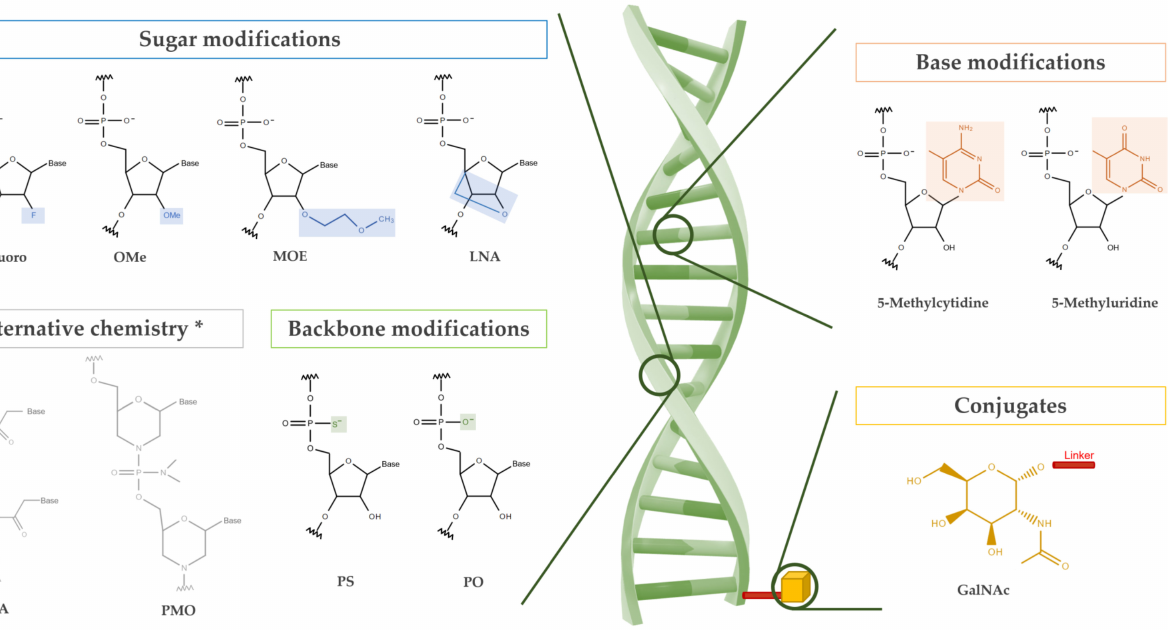
Figure 1. Schematic depicting the most commonly used oligonucleotide modifications. OMe: 2 (cid:48) -O-methyl, MOE: 2 (cid:48) - methoxyethyl, LNA: locked nucleic acid, PS: phosphorothioate, PO: phosphorodiester, PNA: peptide nucleic acid, PMO: phosphorodiamidate morpholino oligomer, GalNAc: N-acetylgalactosamine. * These chemistries are used in single stranded